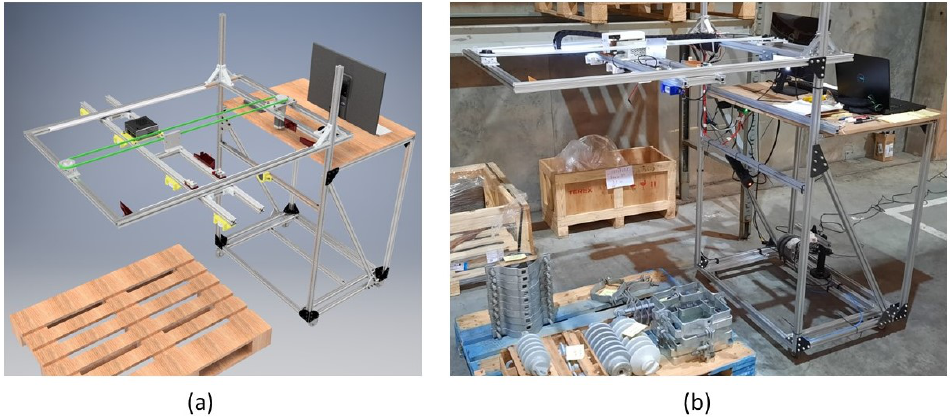
Figure 2. Mechanical device: ( a ) project and ( b )